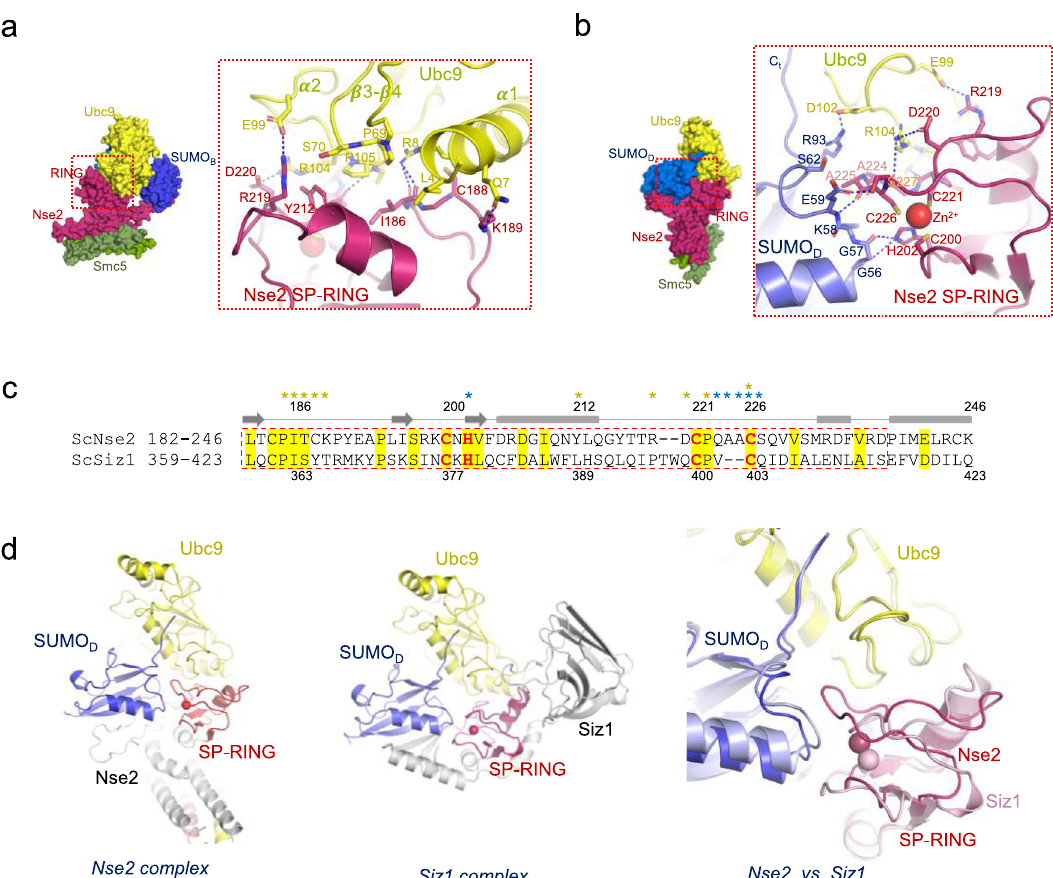
Fig. 7 Extensive SP-RING interaction with the E2-SUMO D thioester mimetic. a Cartoon representation of the complex between SP-RING Nse2 (Ile186 to Ser227) and Ubc9. b Cartoon representation of the complex between SP-RING Nse2 (Ile186 to Ser227) and SUMO D (Gly53 to Arg93). c Sequence alignment of SP-RING domains of yeast Nse2 and Siz1. Asterisks indicate residues that make interactions with Ubc9 (yellow) and SUMO D (blue). Secondary structure elements are depicted above (middle). d Structural alignment comparison of SP-RING domains in Nse2 and Siz1 complexes (5JNE).